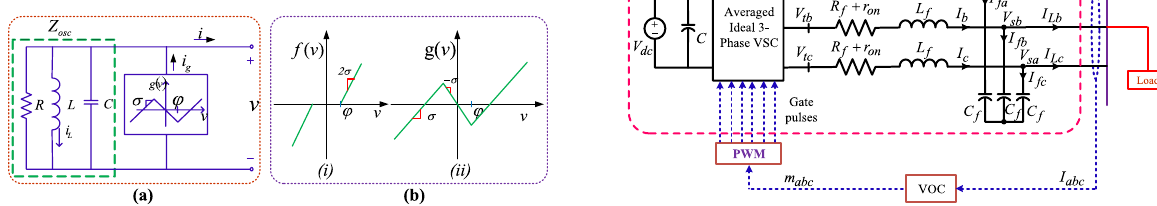
Fig. 5 a Electrical representation of the DZo; b (i) Dead-zone characteristics, (ii) VDCS characteristics